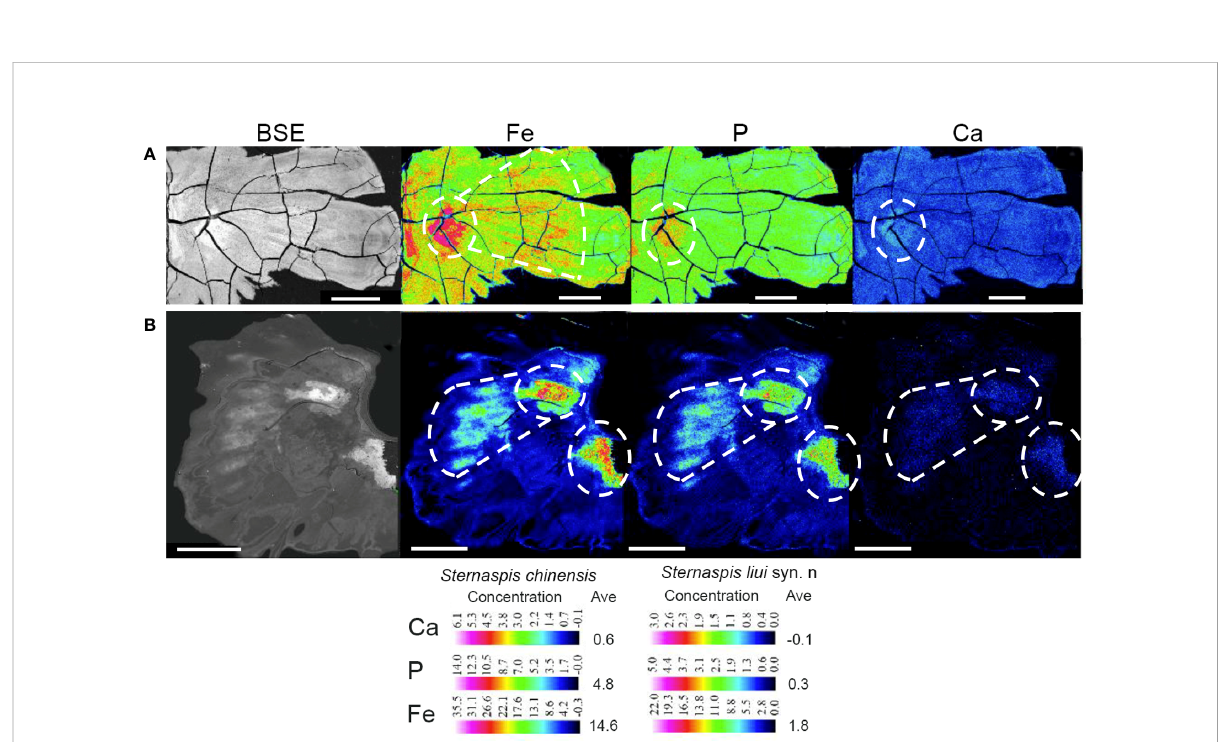
FIGURE 4 Backscattered electron (BSE) images and electron probe microanalysis (EPMA) elemental maps of Fe, P, and Ca in shield plates of (A) Sternaspis chinensis and (B) Sternaspis liui syn. n. Ave, average concentration. BSE image scale bar: 100 µm; Fe, P, and Ca EPMA map scale bar: 500 µm. White circles, high element abundance.